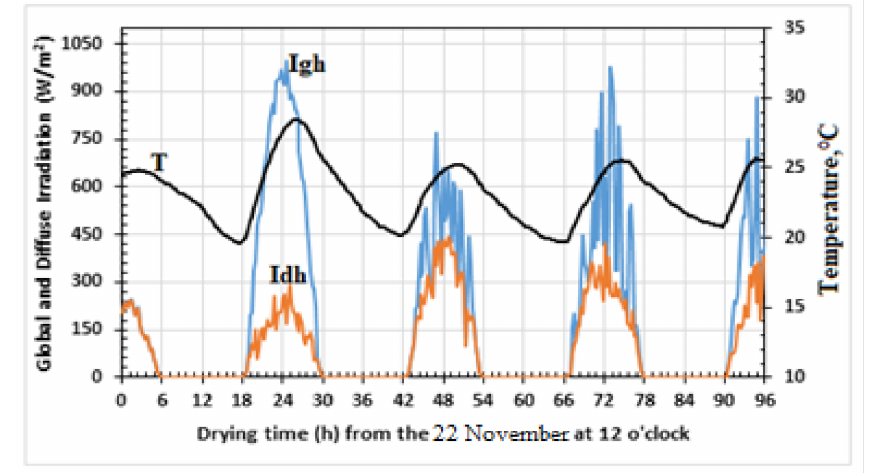
Figure 3. Ambient temperature as well as global and direct solar irradiation on a horizontal plane in Yaound é from 22 November 2018 (taken from